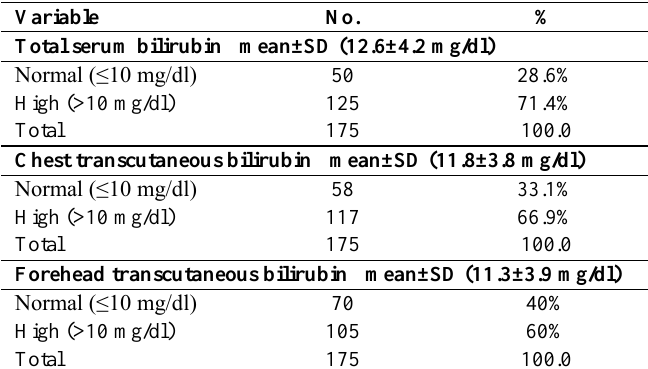
Table (4): Total serum and transcutaneous bilirubin of jaundiced